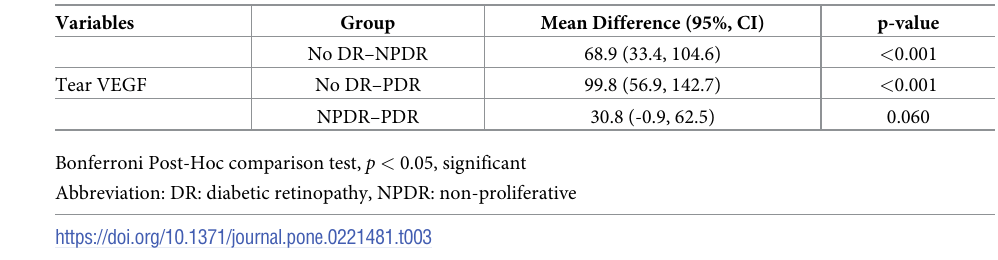
variables ( p < 0.25) among the associated factors were included in the multiple linear regres- sion. Smoking status was included, as it was of clinical importance. The results show that the